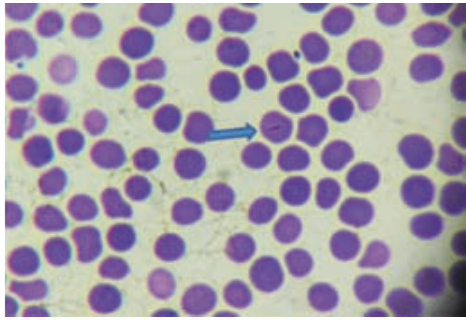
Fig. 1. Fields stained blood smear with rod shaped Theileria orientalis organism in an erythrocyte